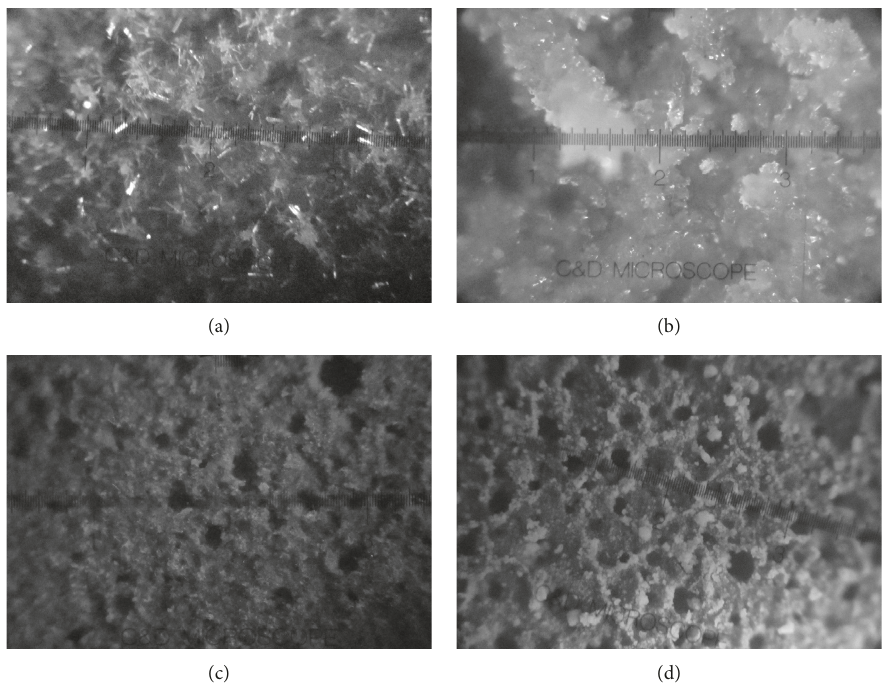
Figure 9: (a) Sample SMF1 showing a needle-like structure after 1 month of exposure to magnesium sulfate solution (optical microscope at 10x magnification). (b) Sample SMF1 showing white precipitant after 6 months of exposure to magnesium sulfate solution (optical microscope at 10x magnification). (c) Sample SMSB2 showing the fresh surface after 1 month of exposure to magnesium sulfate solution (optical microscope at 10x magnification). (d) Sample SMSB2 showing very little precipitants on the surface after 6 months of exposure to magnesium sulfate solution (optical microscope at 10x